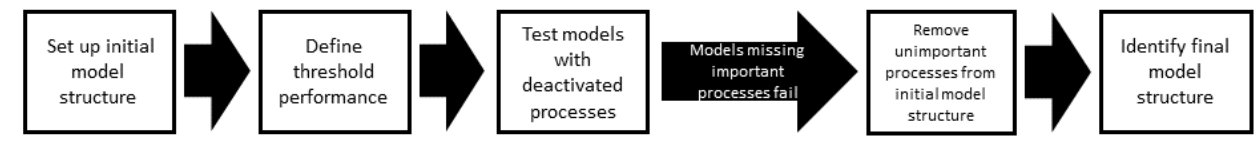
Figure 4. Flow chart for the method of incremental model breakdown. Table 1. Structural elements of the models and amount of parameters. GW is groundwater, DW is drinking water and ET is evapotranspiration. Light gray indicates active components. Dark grey indicates disabled components. The “ × ” symbol marks the deactivated components. Rain distribution Groundwater (GW) Number Canopy Surfaces